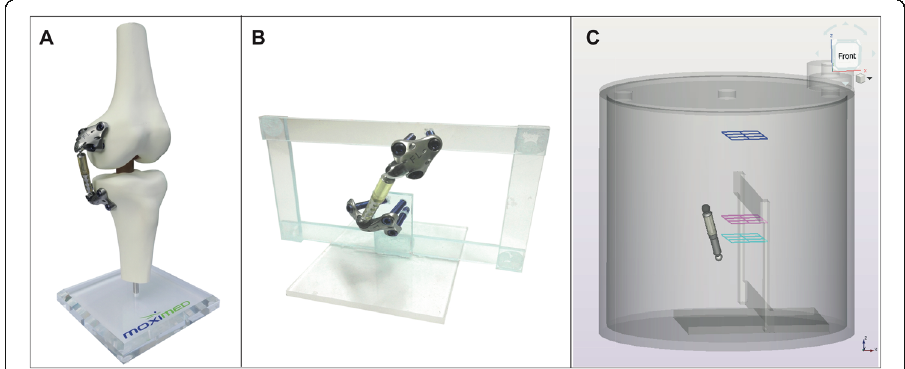
Fig. 3 Atlas® Knee System a mounted to a model knee joint, b mounted to the acryl frame used for positioning inside the cylindric phantom, and c technical drawing of acryl frame with load absorber inserted in the phantom (analyzed ROI positions are visualized, turquoise: lateral tibia head, magenta: femur head, dark blue: reference region). The view on the phantom (CAD-drawing) is from an anterior lateral position (plates and screws of the load absorber were not